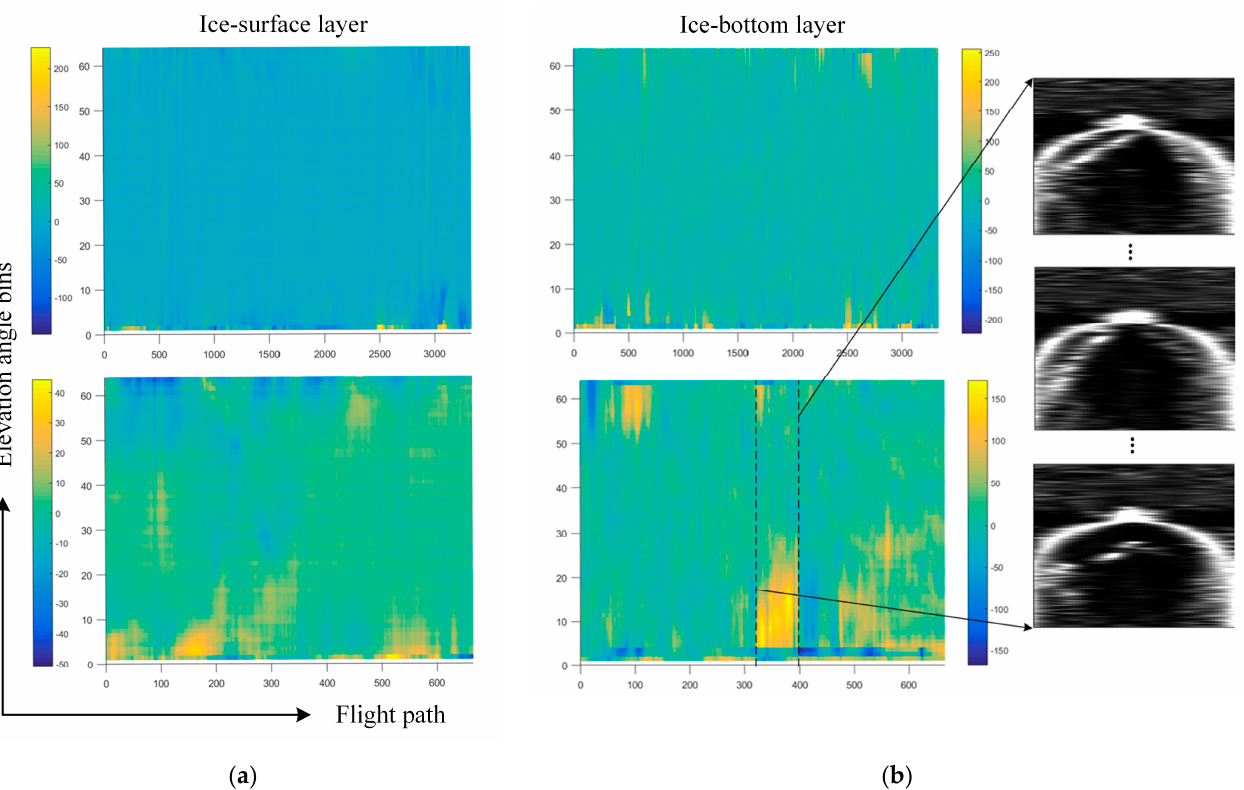
Figure 12. Elevation differences of reconstructed layers using the results extracted by the MsANet. Unit: meter. ( a ) Elevation differences of the ice-surface layer. ( b ) Elevation differences of the ice-bottom layer. The topology slices between the two dashed lines in ( b ) are displayed on the right.